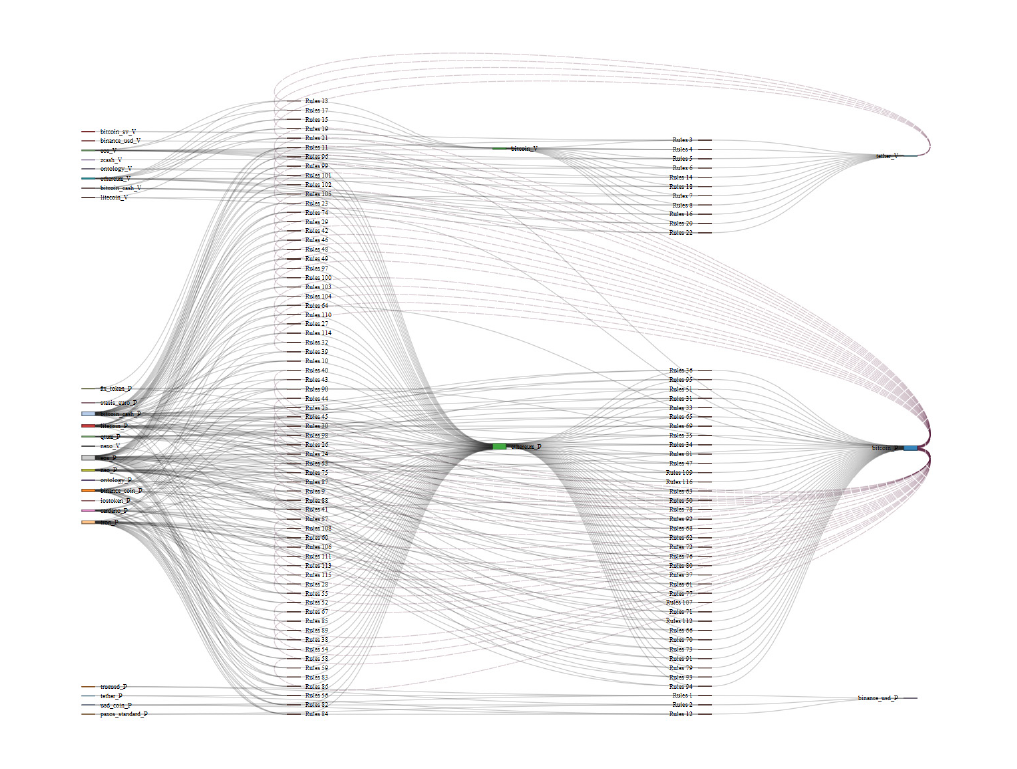
Figure 12. Sankey diagram that shows the direction from the antecedent (LHS) to the consequence (RHS) for the 116 rules of Subset 2.